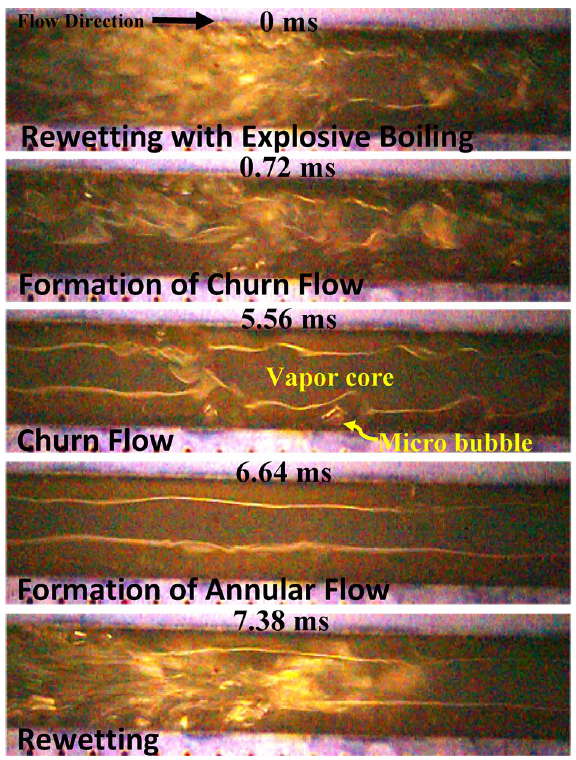
Figure 10. Flow pattern transitions of flow boiling in SiNW microchannels at mass flux, 1000 kg/m 2 s and heat flux, 68 W/cm 2 using dielectric fluid, HFE-7100 at frame rate 70,000